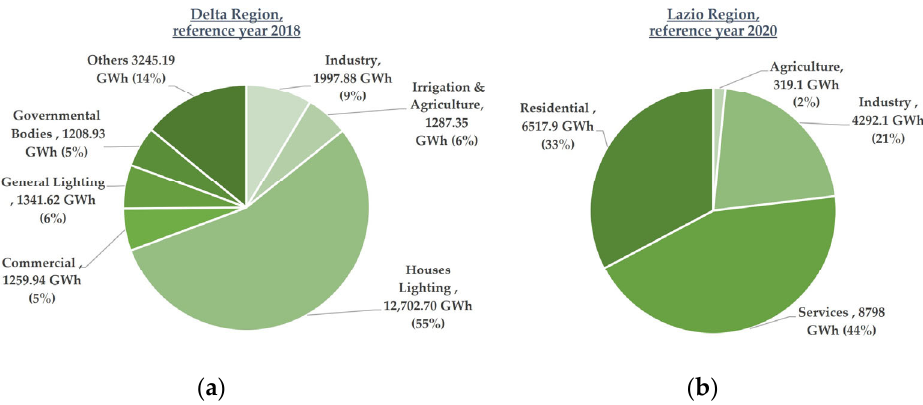
Figure 10. ( a ) The distributed energy by GWh by user category, and the percentage of each category in the Delta region for the year 2017/2018 based on reference [115]; ( b ) Electricity consumption by user category, and the percentage of each category until 31 December 2020 based on the reference [116]. The suggested key concepts can reduce domestic and agriculture categories’ electricity shares (61% in the Delta and 35% in the Lazio regions).